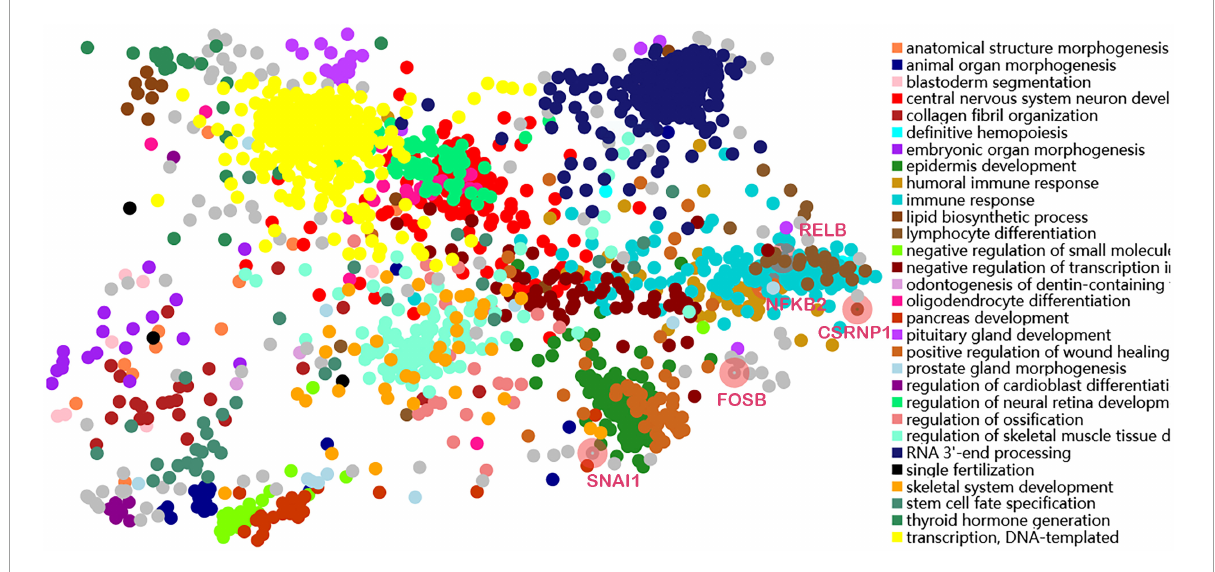
FIGURE7 Transcription factors-DEGs coregulatory networks and GO